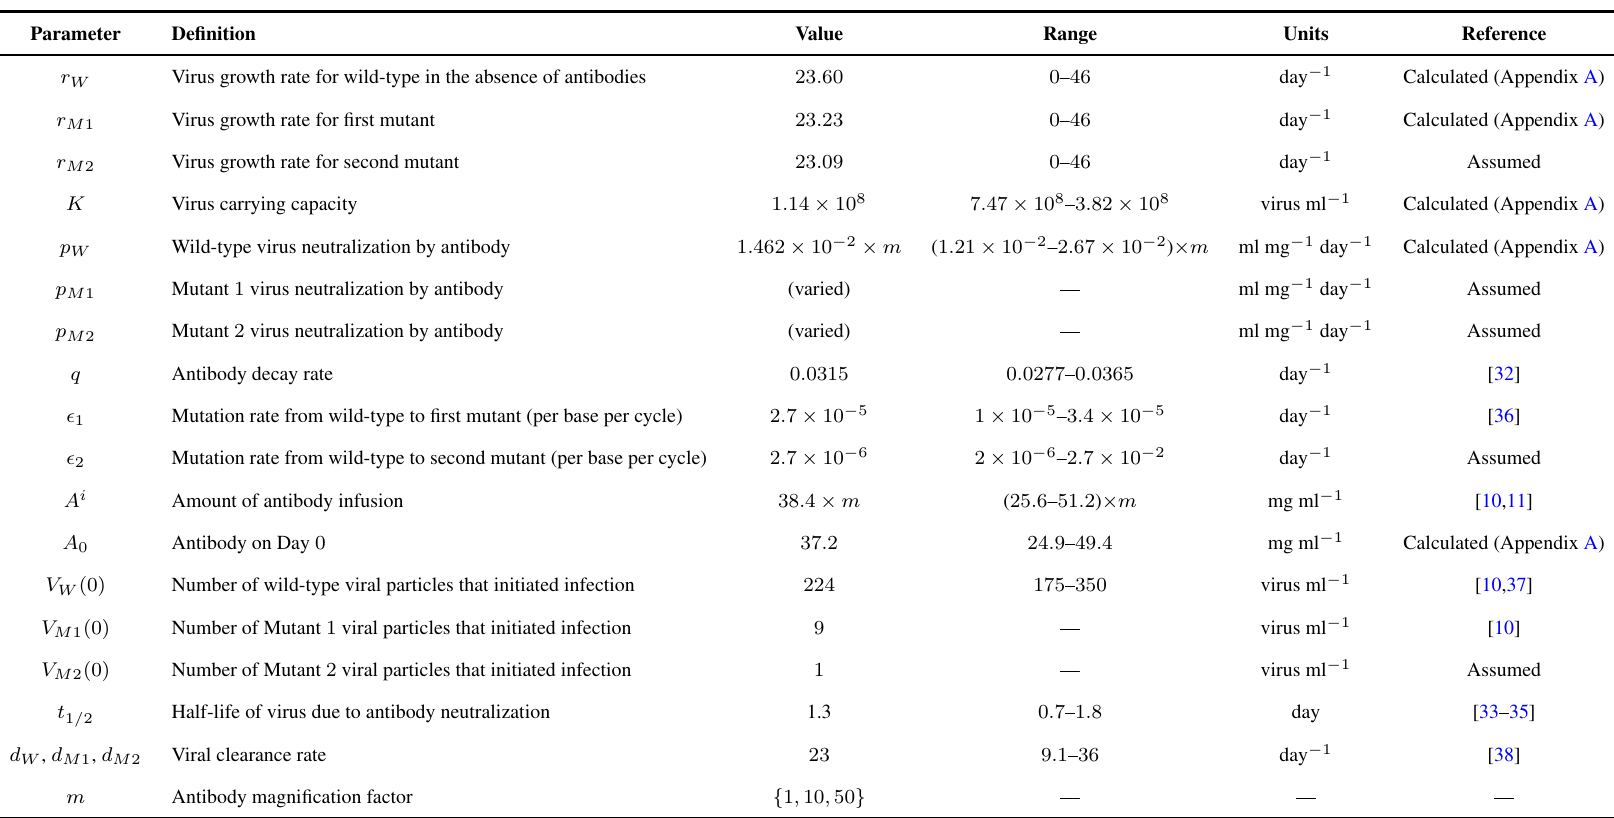
Table 1. Parameter